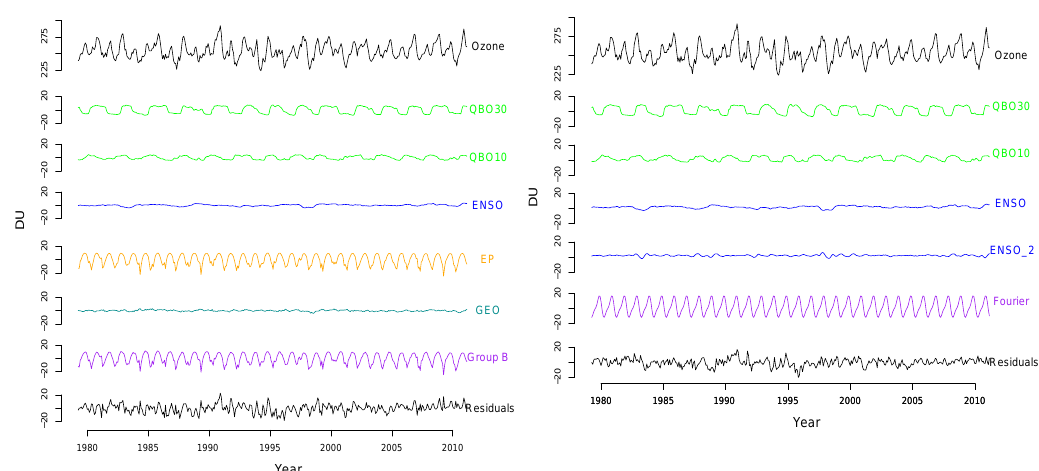
Figure 8. Results of the PHYS regression (left plot) and of the STAT regression (right plot) in Bogota, Colombia. “Fourier” is defined as the sum of the harmonic components that describe seasonal variation in ozone and the “group B” term is defined as the sum of EP and GEO, describing the seasonal component according to the PHYS model. QBO10 and QBO30 represent the QBO index at 10 and at 30hPa,